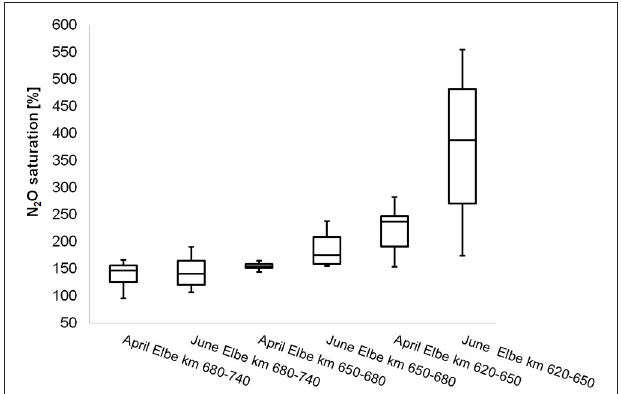
FIGURE 4 | N 2 O water saturations (%) of different transect parts with according Elbe stream km, including the Hamburg port area (km 620–650), the Elbe river (km 650–680) and beginning of salinity gradient of the Elbe estuary up to the North Sea (km